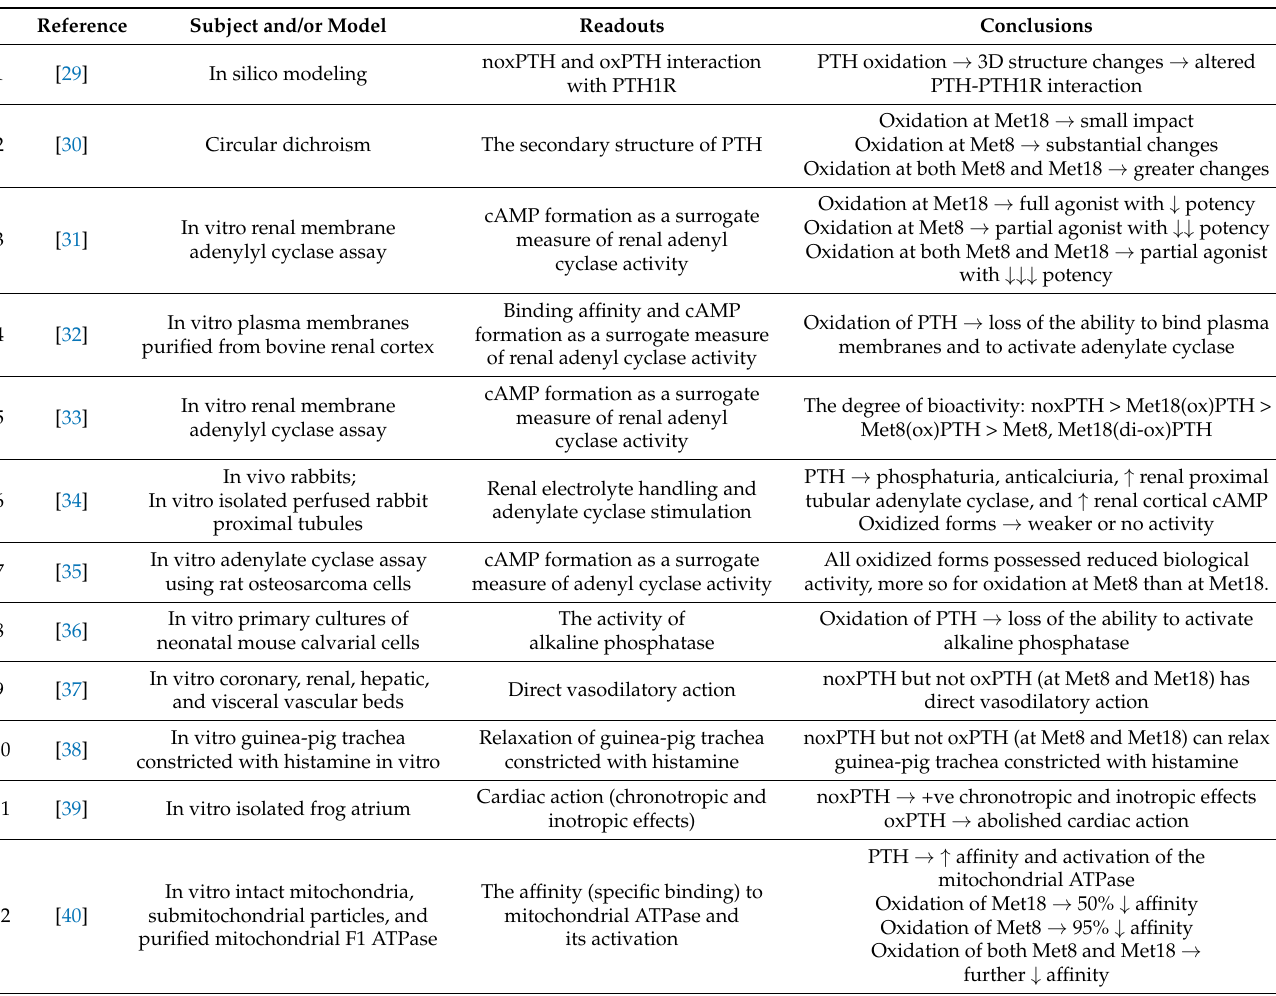
Table 1. Preclinical studies on